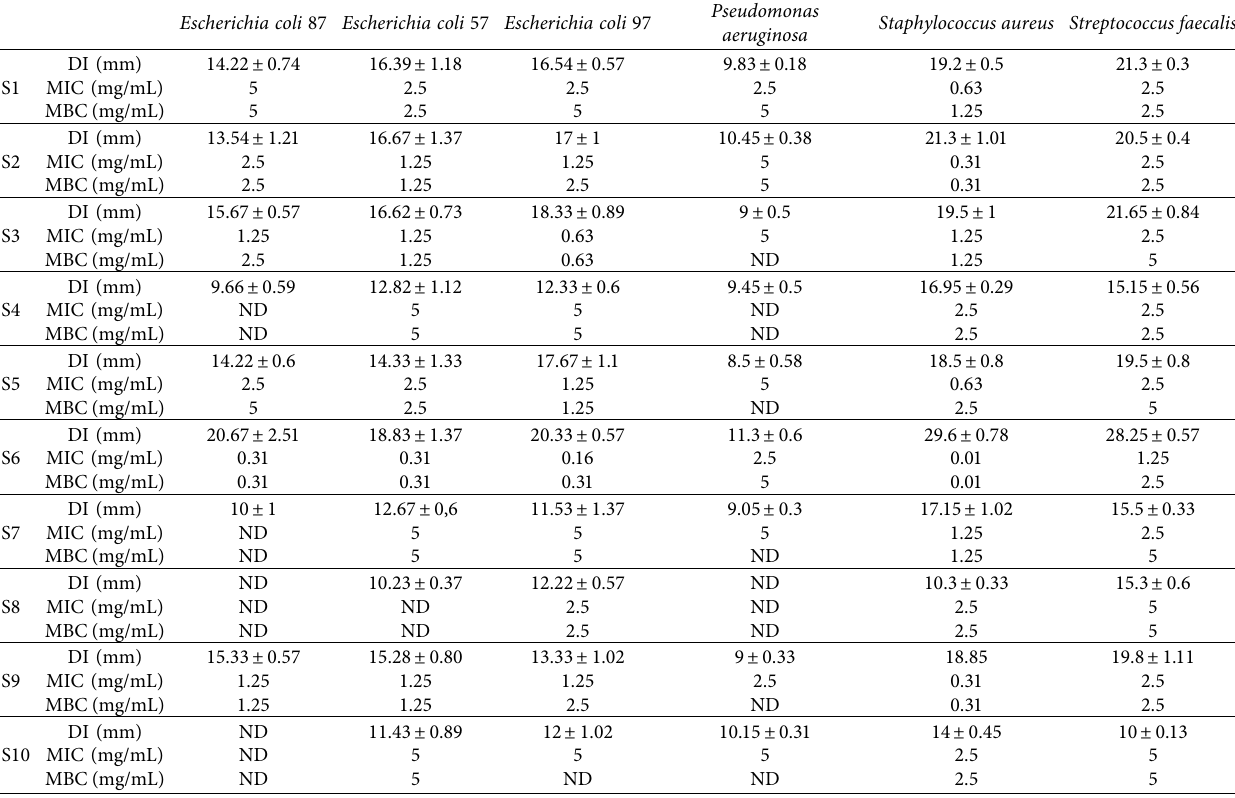
Table 5: The diameter of inhibition zone (mm), the minimum inhibitory concentration (mg/mL), and minimal bactericidal concentration (mg/mL) of Palestinian propolis